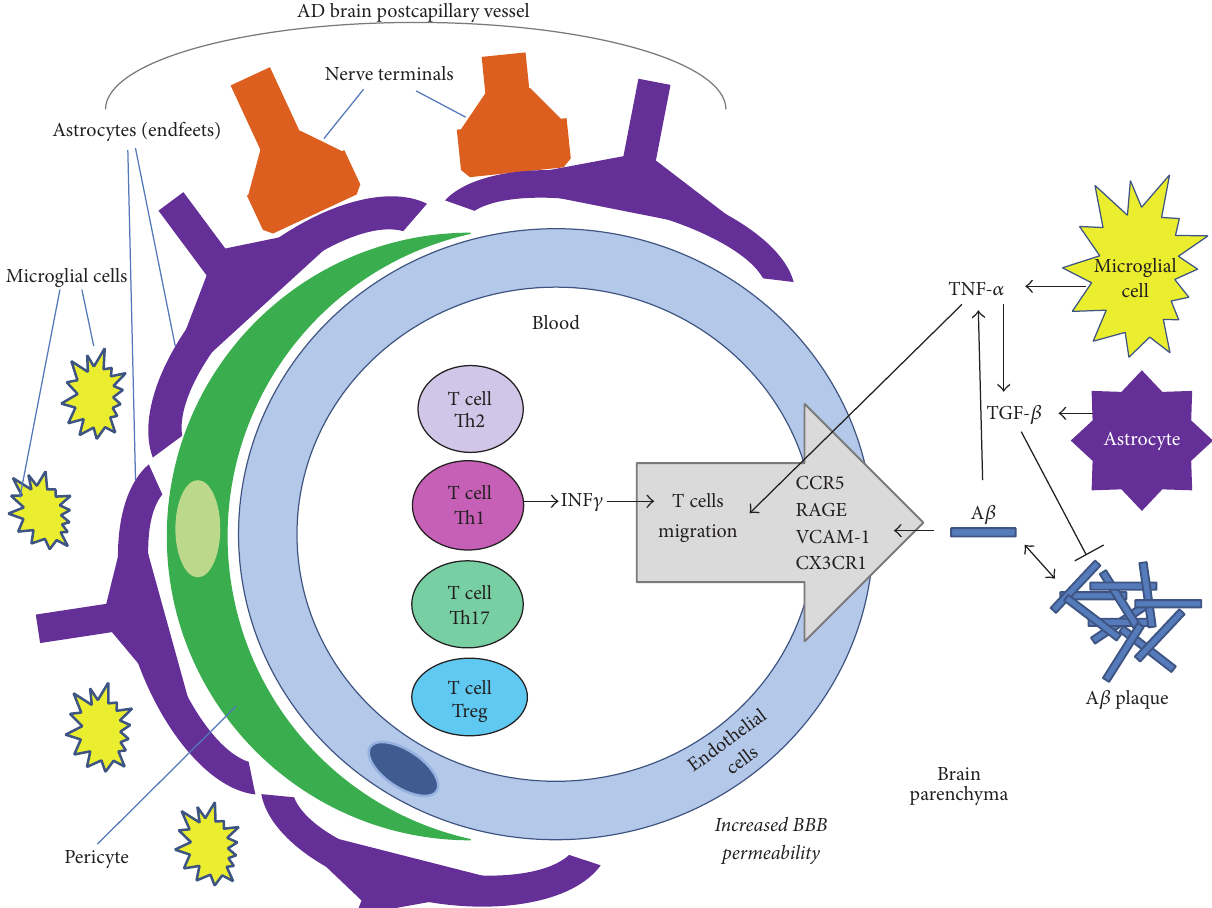
Figure 2: T lymphocytes migration at the blood brain barrier (BBB) in AD. The key role of the BBB is defending the brain against the harmful influence of peripheral factors. In AD the permeability of the BBB is increased, and the migration of peripheral immune cells contributes to the progress of neuroinflammation in the brain. In response to A 𝛽 stimulation from the parenchyma, the transmigration of immune cells from the blood into the brain is mediated by VCAM-1. At postcapillary vessels the immune cells cross the BBB upon interaction with the CX3CR1 receptor on endothelial cells. Other key mediators of the immune cells’ migration are the RAGE receptor and the CCR5 chemokine receptor. Moreover, A 𝛽 activates microglial cells to produce TNF- 𝛼 , which can promote transendothelial migration of T cells and has the ability to enable astroglial cells’ activation and overproduction of TGF- 𝛽 1, which in turn may lead to decreased A 𝛽 plaque